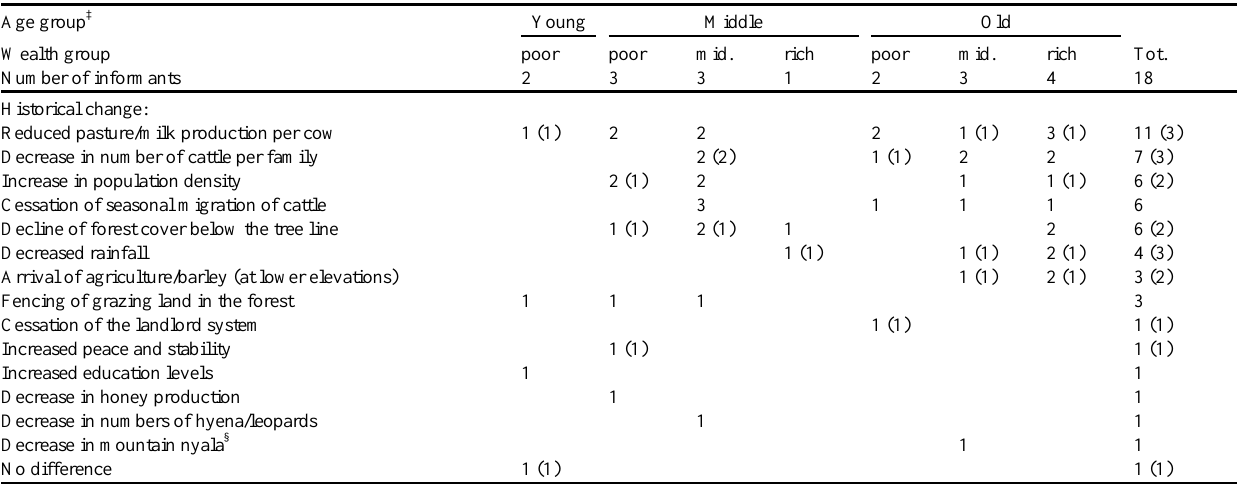
Table 1 . The most important historical changes cited by the informants to have occurred during their lifetime, separated by age and wealth groups.